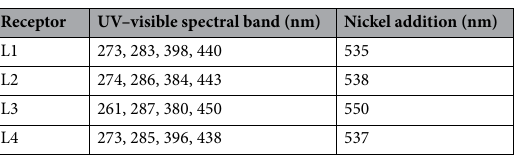
Table 1. UV–visible spectral bands of receptor L1-L4 with addition of nickel (II).